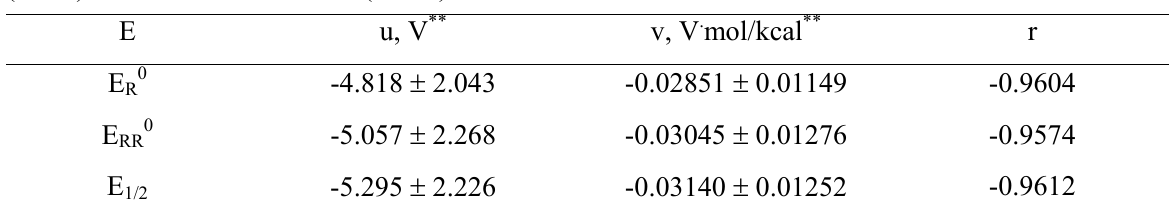
values ( vs saturated Hg 1/2